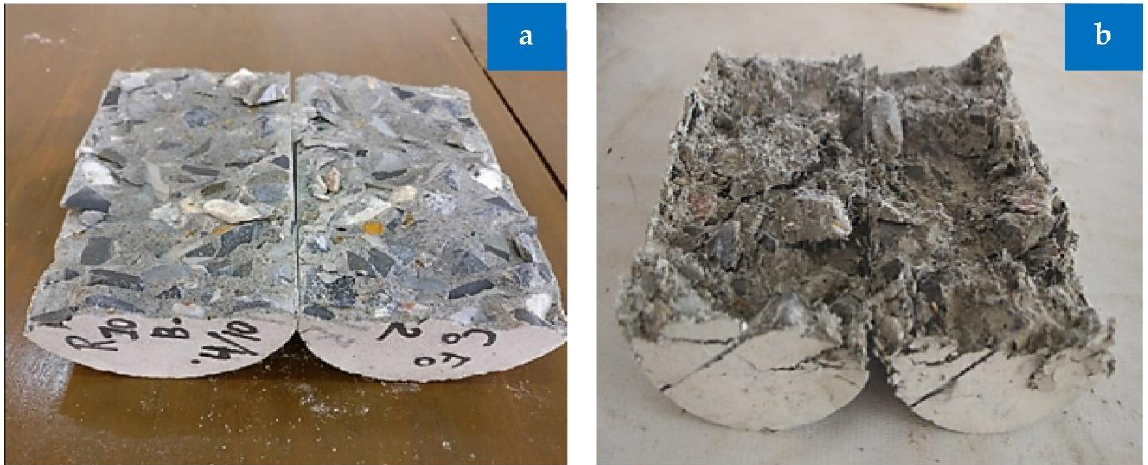
Figure 15. Splitting cylinder failure: ( a ) reference and ( b ) combination of RCA, rubber, and fibers [44]: used as per Elsevier permissions.